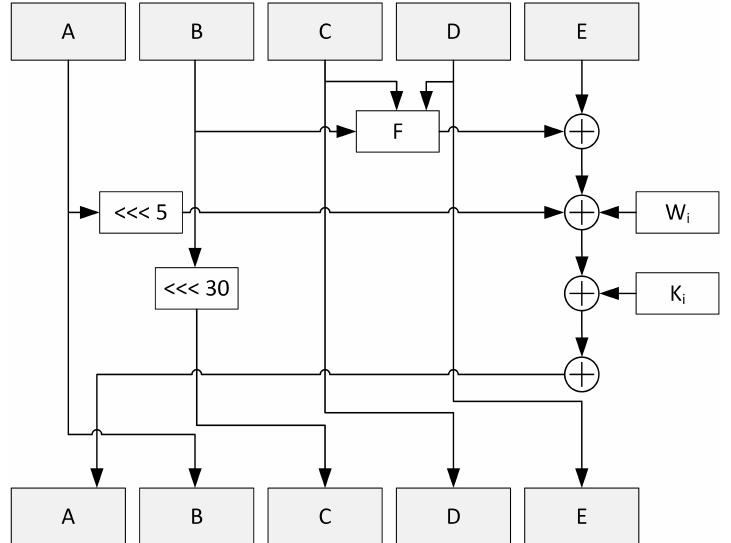
Figure 4. SHA-1 algorithm round scheme. Variables A to E are assigned values of corresponding H registers from the previous block or H(0) for the first block. The W array is generated—the first 16 words are 32-bit chunks of the processed block and subsequent words are calculated with Equation (2).